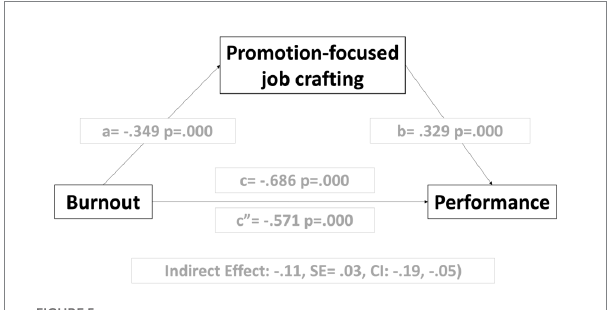
FIGURE 5 Results in mediation models of the promotion of job crafting on the influence of burnout on